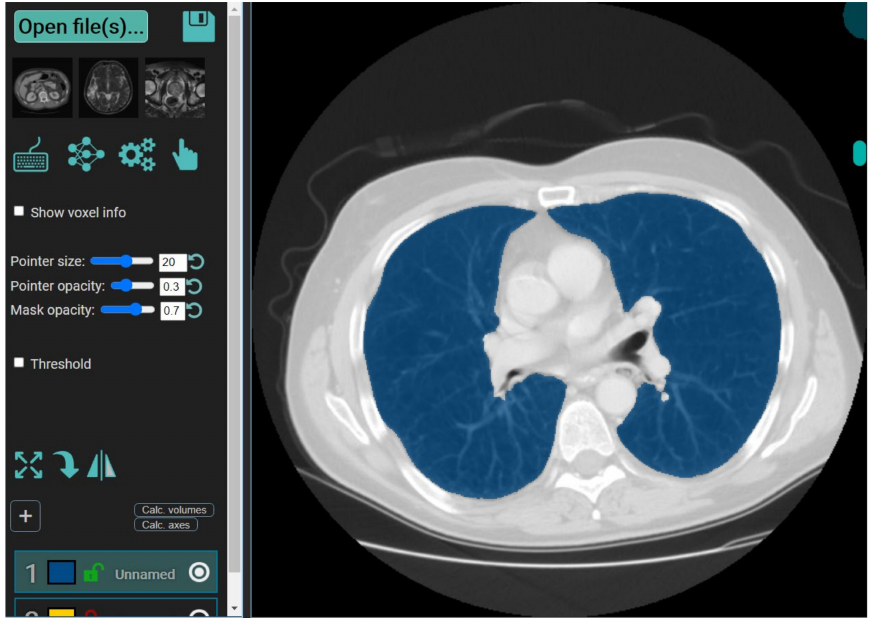
Figure 8. Segmentation of the lung in CT slice using the MedSeg tool.